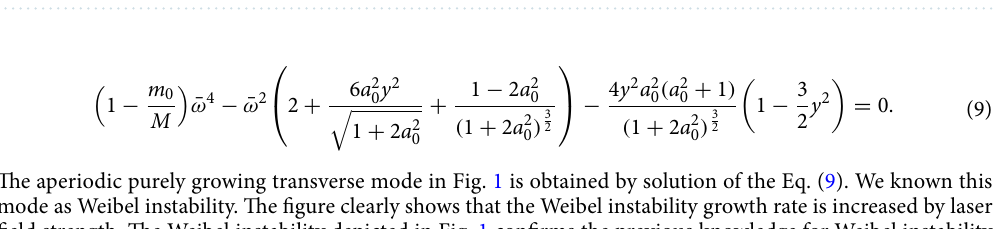
Figure 1. The growth rates of the Buneman and Weibel instabilities in the uncoupled limit, by the solution of the Eq. (8). Here γ = Re ¯ ω for blue, and γ = Im ¯ ω for red, black and green lines. The normalized amplitude of radiated laser field is a 0 = 1, 2, 3 for red, black, and green colors, respectively. We consider the ratio of the mass of an electron and ion as m 0 / M = 1 / 1838